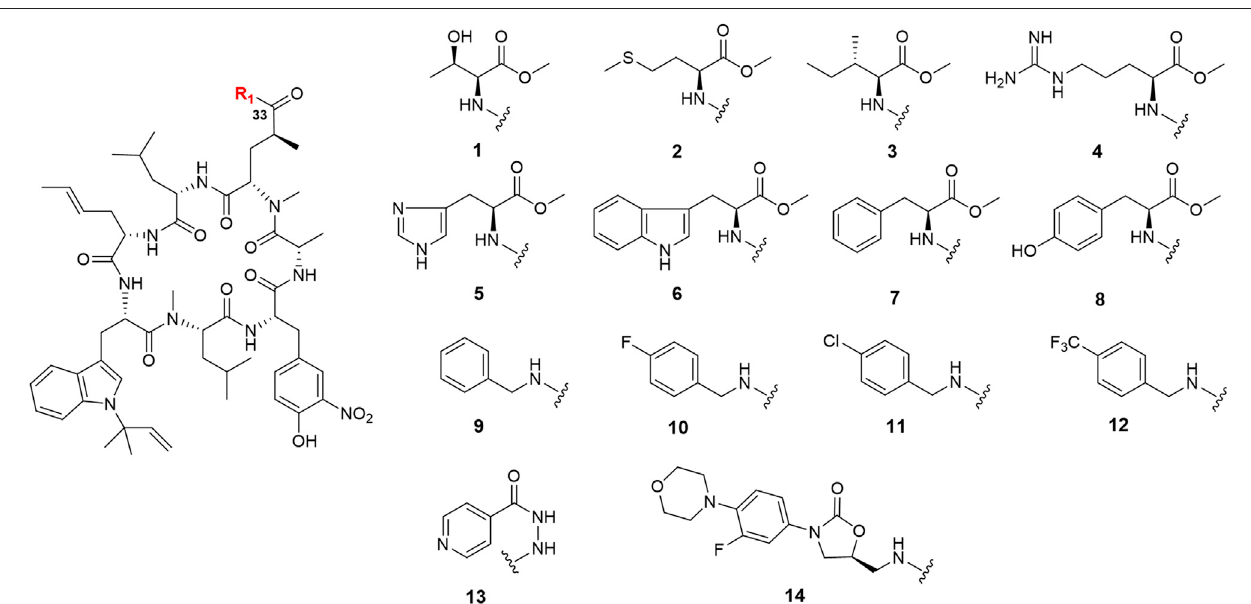
FIGURE 2 | Structures of ilamycin NJLs modi fi ed at C-33 (compounds 1 – 14 ).